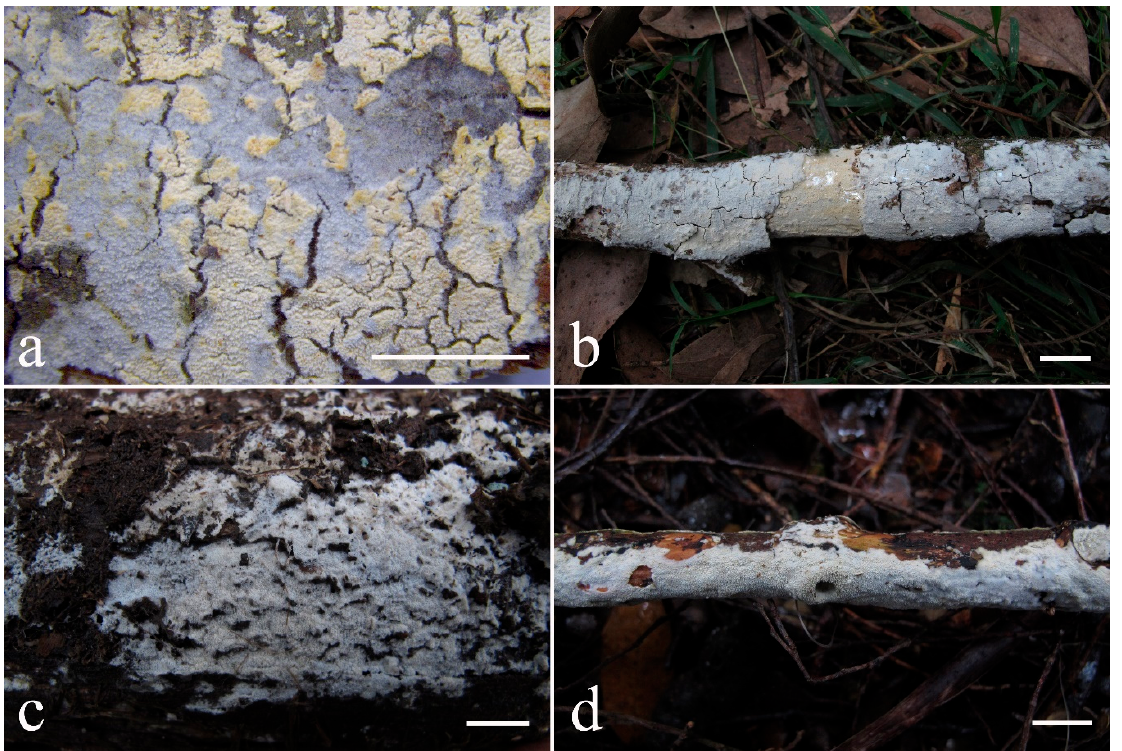
Figure 30. Basidiocarps of Xylodon subserpentiformis . ( a ) LWZ 20180513-28 (holotype); ( b ) LWZ 20180509-2 (paratype); ( c ) LWZ 20180512-16 (paratype); ( d ) LWZ 20180515-19 (paratype).—Scale bars: a = 5 mm; b, d = 2 cm; c = 1 cm.